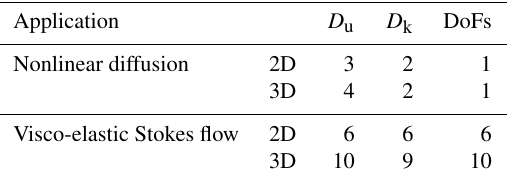
Table 1. Number of unknown ( D u ) and known ( D k ) fields, as well as per grid cell DoFs used to assess, e.g. the T eff metric in the per- formance scaling